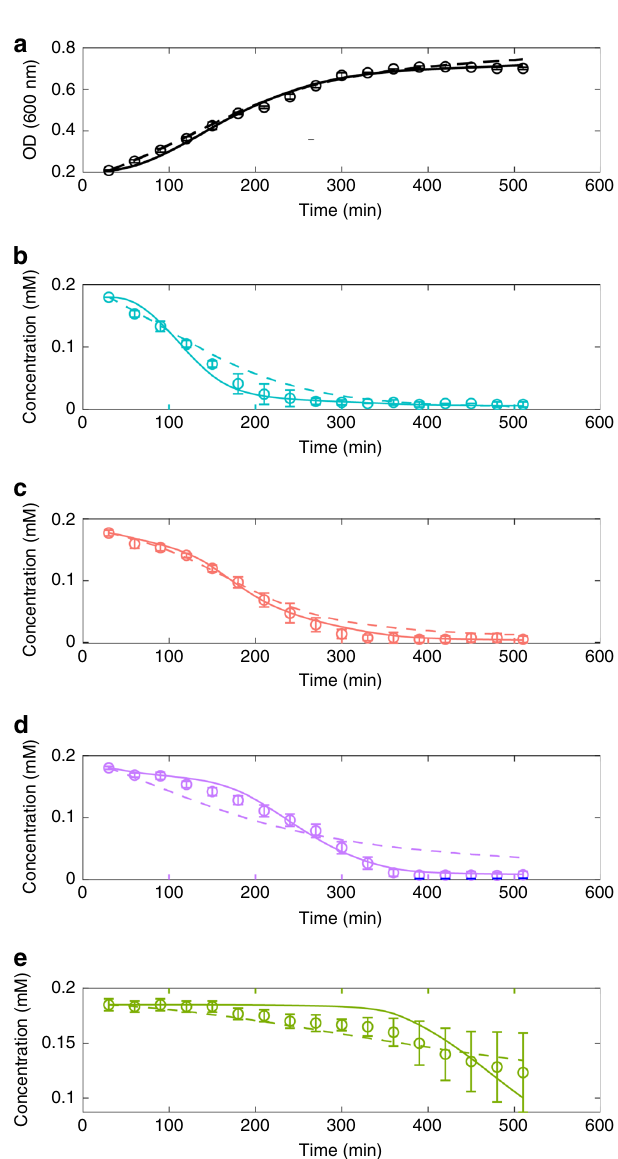
Fig. 6 Modelling the multi-auxic growth. Simulation outcomes for the two models implemented here for biomass ( a ) and lumped nutrients ( b – e ). Dashed lines represent the prediction for the MMM model. Solid lines represent the prediction for the cybernetic model. Open circles represent experimental data (same data shown in Fig. 4d). Error bars represent SD of two different cell cultures in two independent experiments.